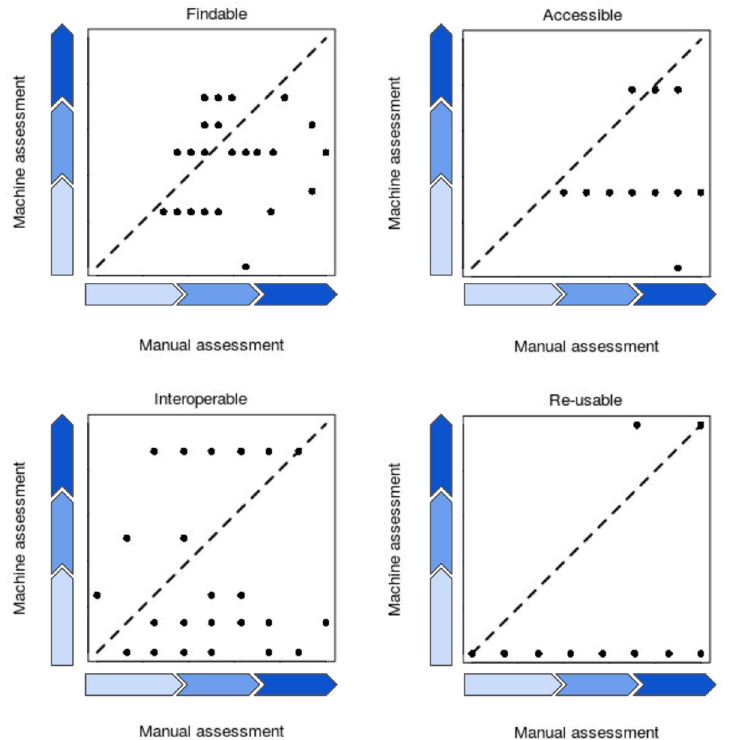
Figure 4. Stylized comparison of manual vs. machine